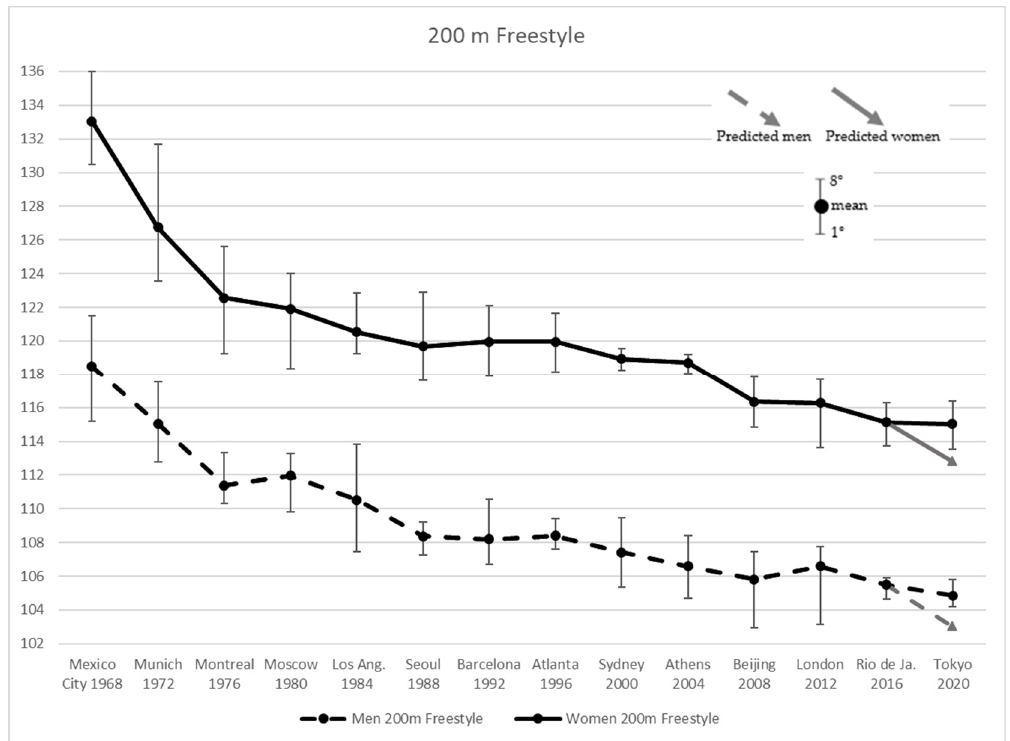
Figure 2. Men’s and Women’s 200 m Freestyle results from Mexico City 1968 to Tokyo 2020 Olympic Games, and the values predicted for the latter.